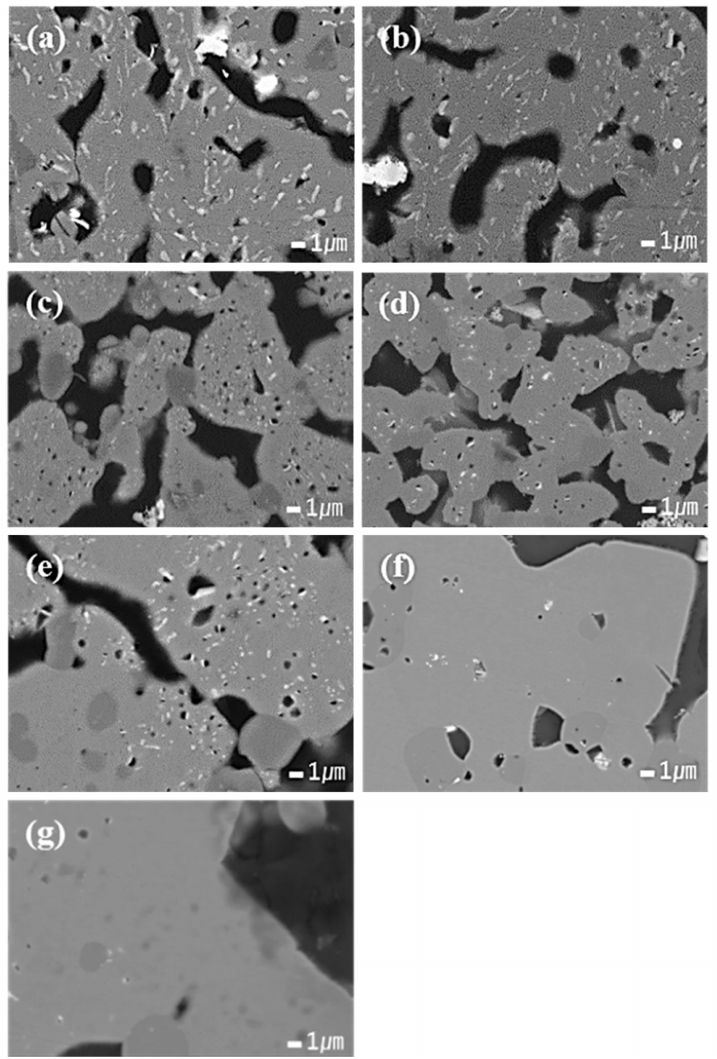
Figure 3. Microstructure of the matrix in reaction region with respect to the reaction Table ( a ) 30 min,